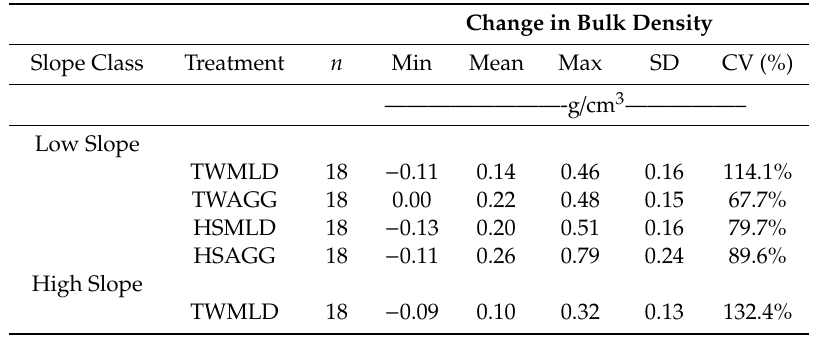
Table 2. Descriptive statistics for the change in bulk density for treatments with a significantly higher in-track mean bulk density than o ff -track, calculated by subtracting the o ff -track mean bulk density from the in-track mean bulk density. The only significant di ff erence at α = 0.05 was between low slope Treatment 4—the forwarder with the aggressive track tethered with the HAAS winch (HSAGG) and high slope TWMLD ( p =